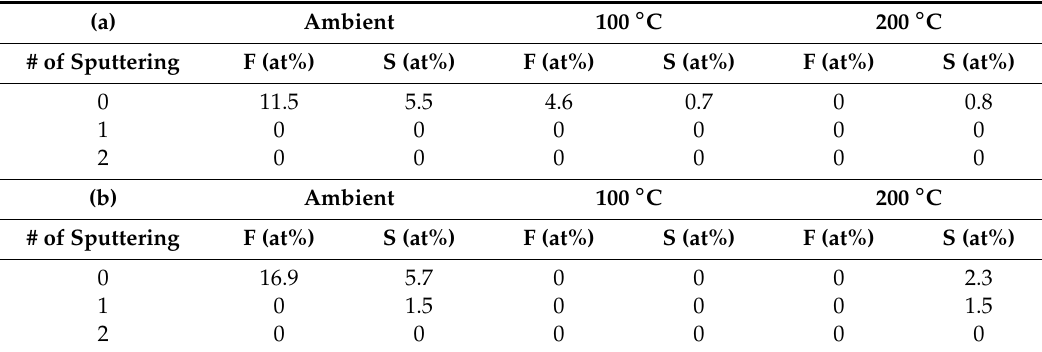
Table 5. The XPS data for amorphous Pd alloy samples on the contact area: ( a ) 3 mm / s and ( b ) 7 mm / s.